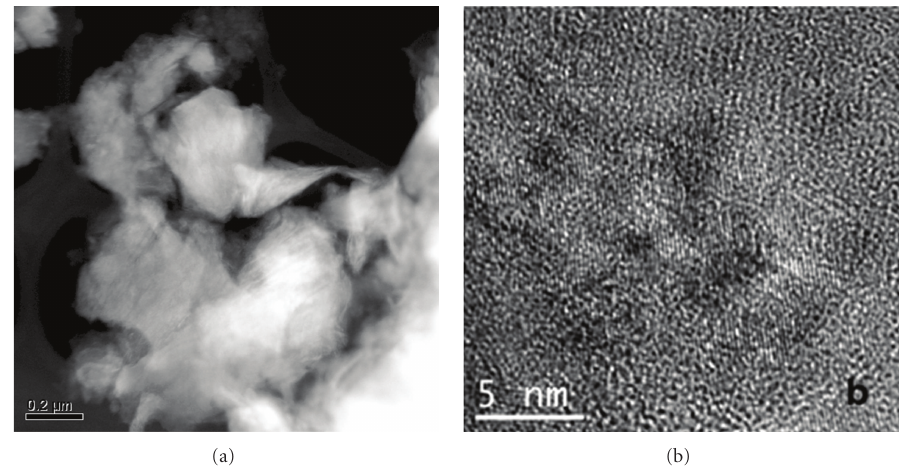
Figure 2: Fe 40 Al 60 nanoparticle TEM micrographs before the corrosion electrochemical tests, (a) Z contrast and (b) high-resolution micro- scopy.